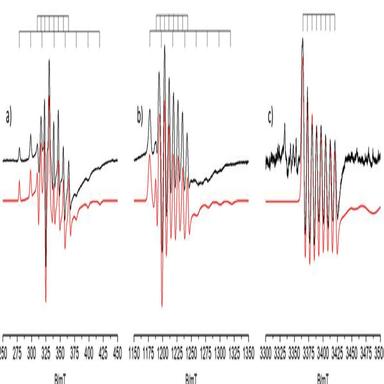
Experimental (black) and simulated (red) CW-EPR spectra of the V/ZSM-5 sample recorded at (a) X-band, (b) Q-band and (c) W-band frequencies. Due to strain effects, the parallel components of the W-band spectrum are unresolved.